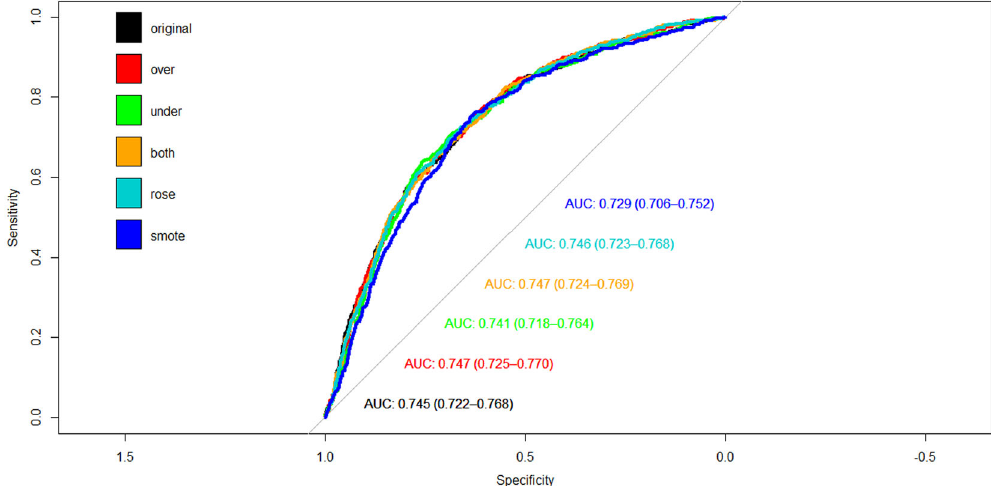
Fig. 2 ROC and AUC of logistic regression models by using balanced dataset and the original dataset. The oversampling (Over), undersampling (Under), bothsampling (Both), random oversampling examples (ROSE), and synthetic minority over-sampling technique (SMOTE) were applied to balance the dataset.